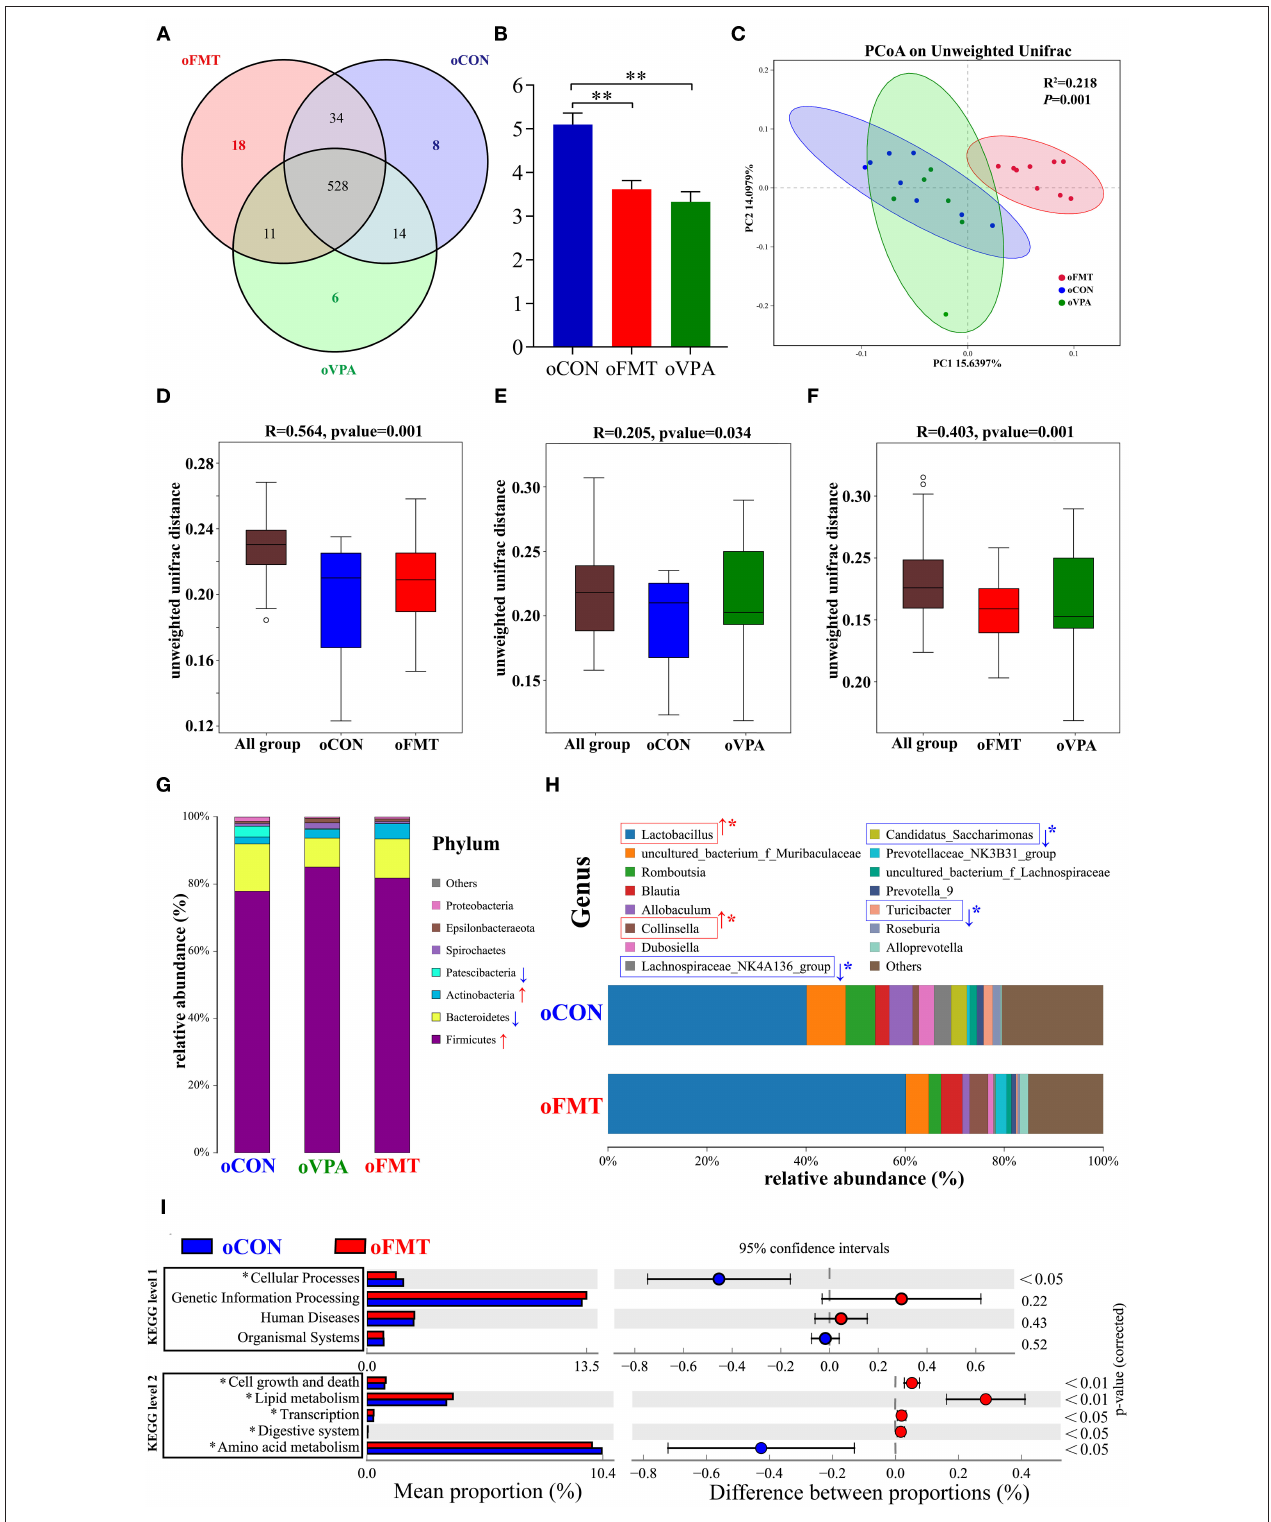
FIGURE 4 | The gut microbiota among oCON, oFMT, and oVPA according to the 16S rRNA data. Impact of FMT on gut microbiota (cecal and fecal microbiota) in offspring rats (oFMT, n = 9; oVPA, n = 6; oCON, n = 8) (red: oFMT; green: oVPA; blue: oCON). (A) Venn diagram of the observed OTUs among oCON, oFMT, and oVPA. (B) The Shannon index (one-way analysis of variance test) of the gut microbiome among oCON, oFMT, and oVPA according to all OTUs data. ** P < 0.01